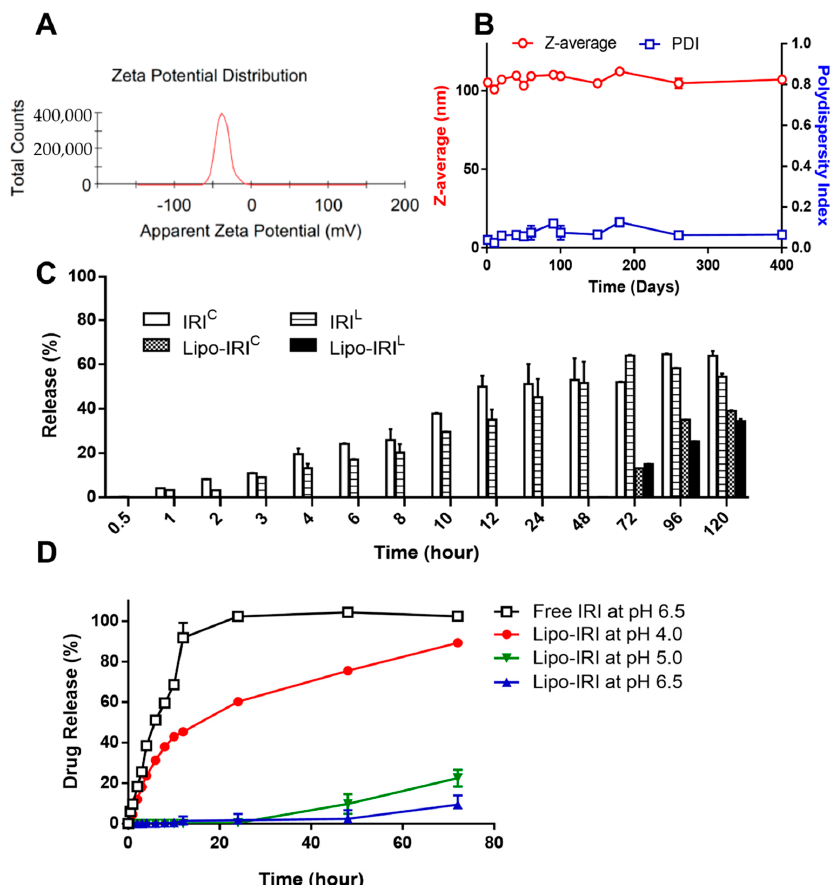
Figure 2. Evaluation of stability of Lipo-IRI. ( A ) The zeta potential was assessed by DLS. ( B ) The z-average and polydispersity index ( PDI ) were estimated after 400 days of storage using a DLS instrument. ( C ) Free IRI and Lipo-IRI were dialyzed in a HEPES buffer at pH 7.4. The contents of IRI L and IRI C in the dialysate were quantified by reversed phase-high performance liquid chromatography (RP-HPLC). ( D ) The IRI and the Lipo-IRI suspension were also dialyzed in a HEPES buffer at pH 4.0, 5.0 and 6.5. The amount of IRI in the dialysate was analyzed. The data are presented as the mean ± SD ( n = 3).